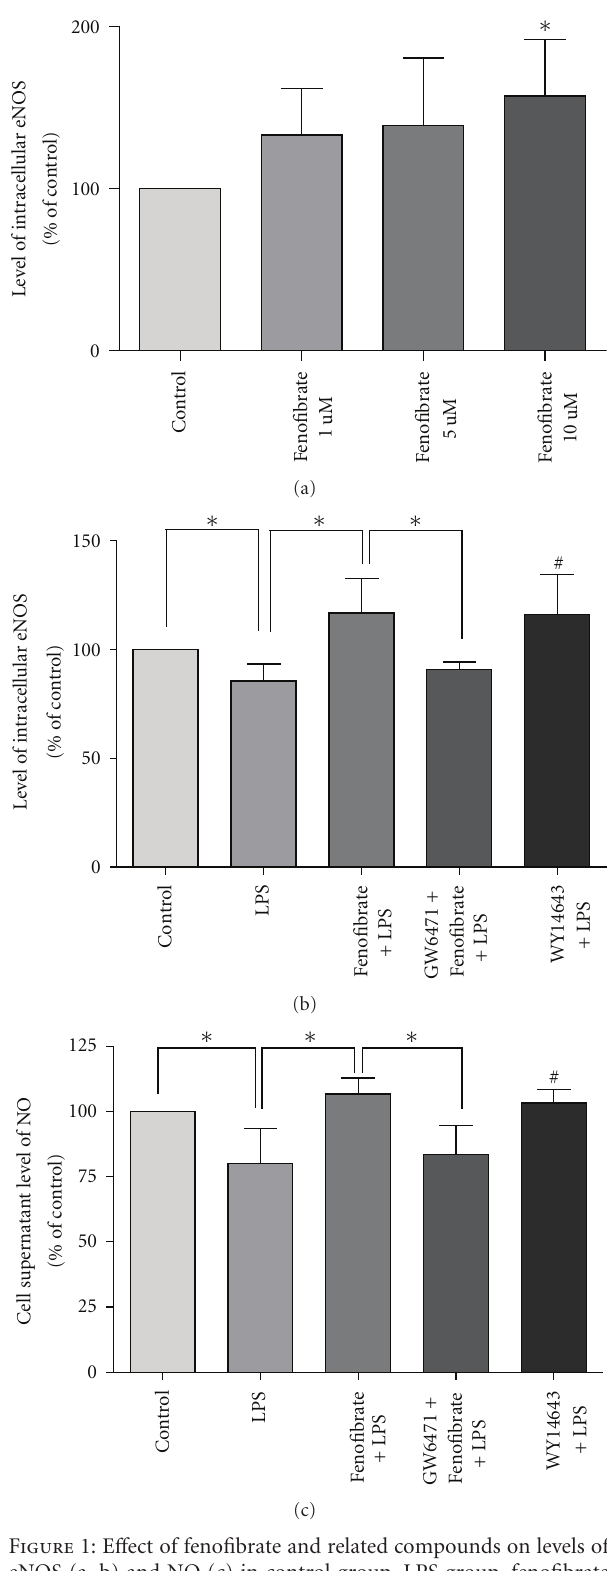
Figure 1: E ff ect of fenofibrate and related compounds on levels of eNOS (a, b) and NO (c) in control group, LPS group, fenofibrate pretreated group, PPAR α antagonist, and agonist group. eNOS and NO were measured by ELISA kits according to the manufacturer’s protocols. Values are expressed as means ± SD. (a) ∗ P < 0 . 05 versus control group. (b, c) ∗ P < 0 . 05; # P < 0 . 05 versus LPS